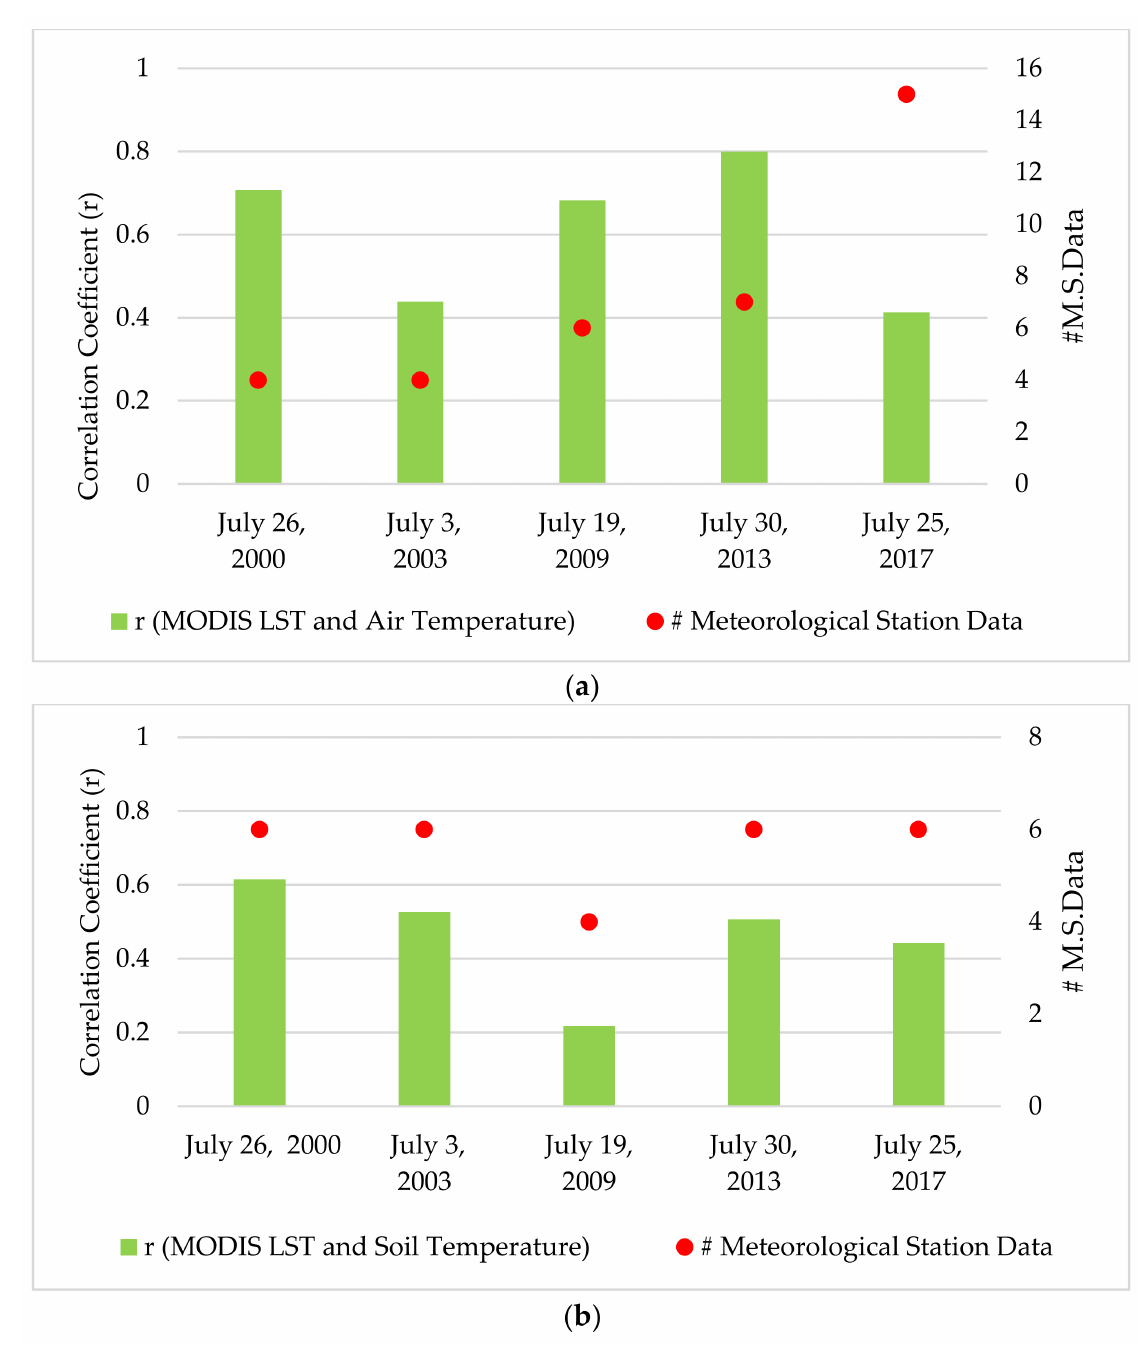
Figure 6. Correlation coefficients between MODIS LST and meteorological parameters (( a ) air temperatures, ( b ) 5 cm soil temperatures) and number of data measured at the